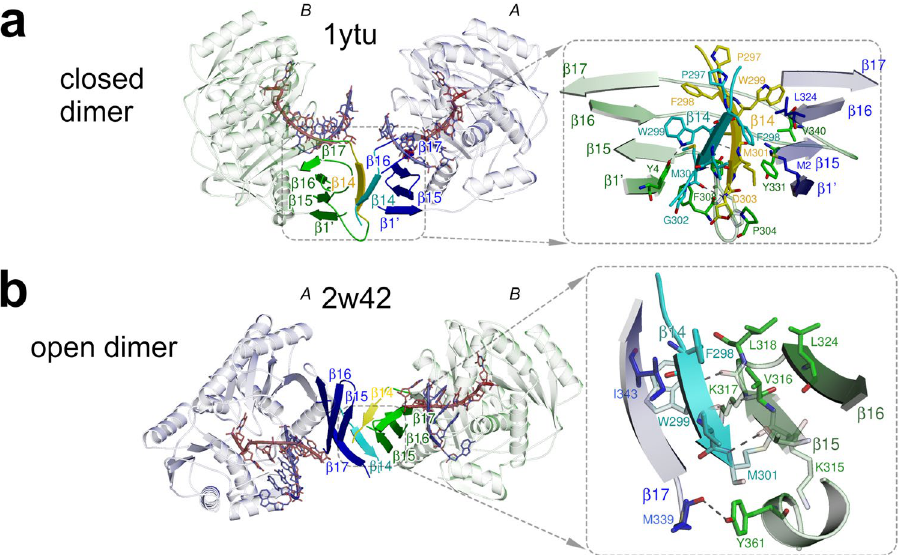
Figure 1. Dimerization of AfAgo. ( a , b ) Protein subunits are coloured blue (protein chain A ) and green (protein chain B ). The interface-forming secondary structure elements are highlighted and numbered according to the PDB ID 2w42 assignment made by PDBsum 52 . The “guide” DNA/RNA strands bound by AfAgo are coloured red, “target” strands—blue. Residues 296–303 deleted in AfAgoΔ are coloured cyan and yellow. Hydrogen bonds are shown as dashed lines. ( a ) AfAgo complex with dsRNA (PDB ID 1ytu, both protein chains as present in the asymmetric unit), the “closed” dimer 19 . ( b ), AfAgo complex with dsDNA (PDB ID 2w42) 21 )—the “open” dimer. β-strands from both subunits assemble into a closed β-barrel structure, with intersubunit interface formed by β14 and β15 strands of neighbouring